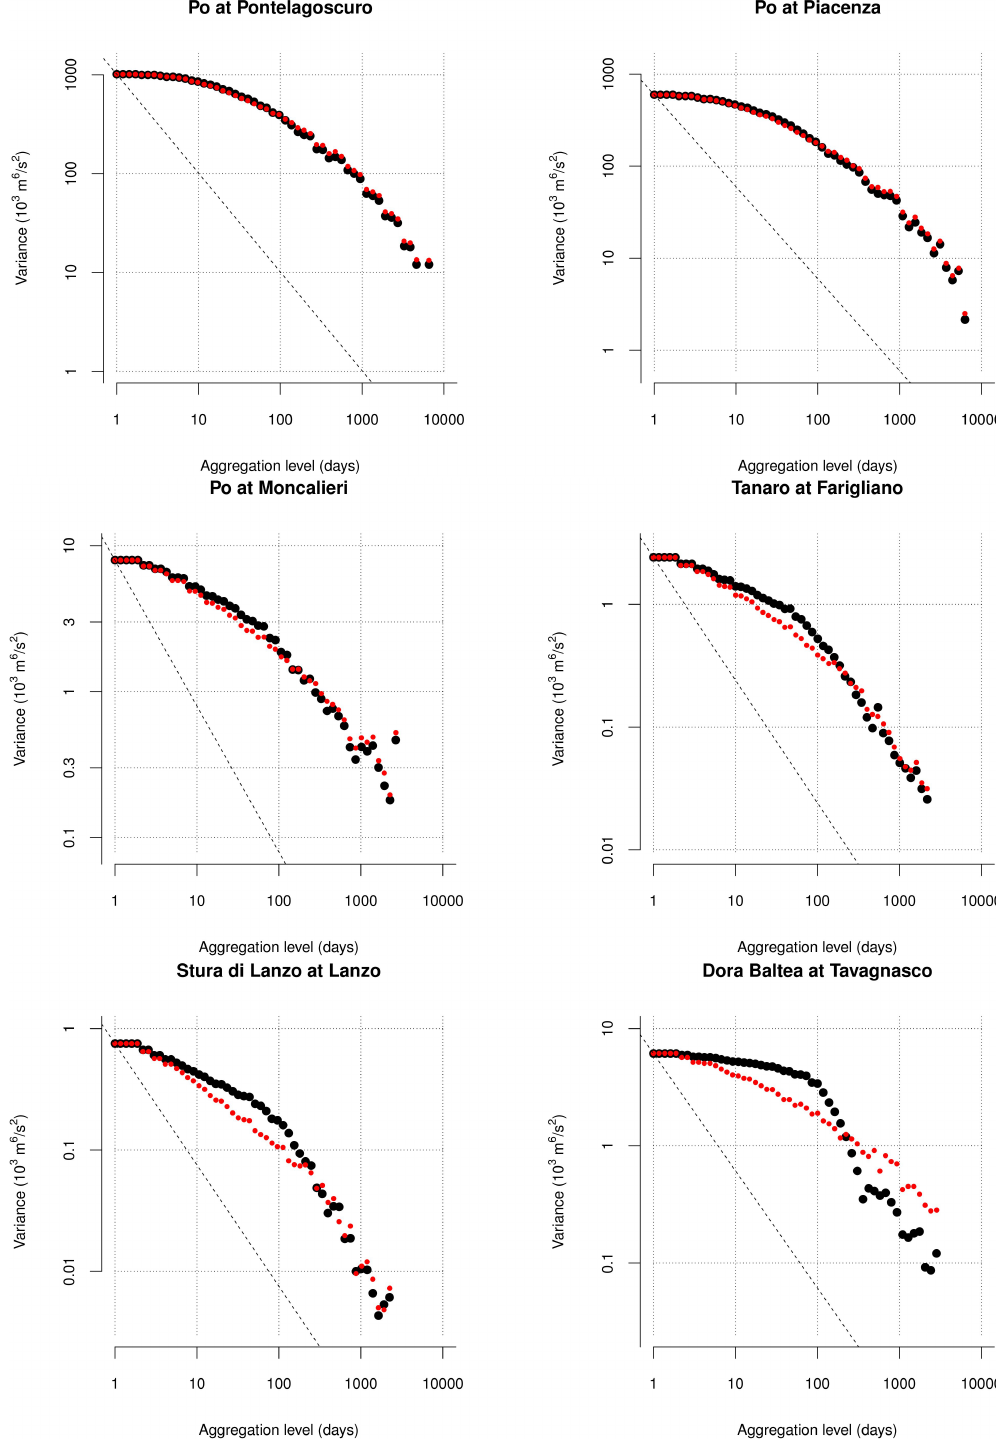
Fig. 8. Analysis of the variance for the considered time series. Black and red symbols refer to original (not deseasonalised) and deseasonalised daily series,